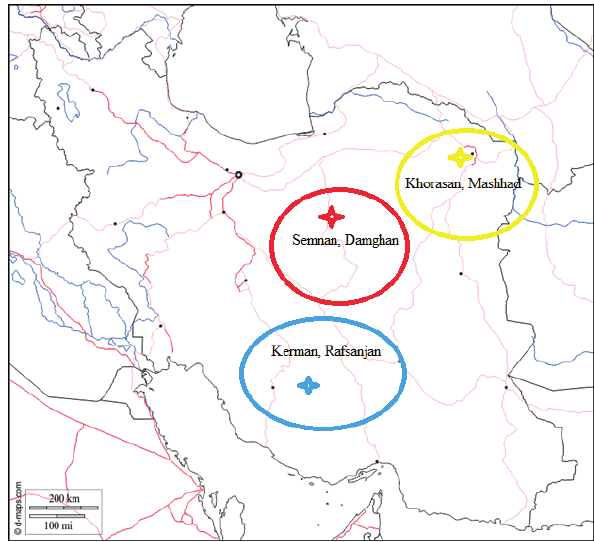
Figure 1. Map of Iran shows the collection sites and provinces where of Pistacia vera species were obtained for this